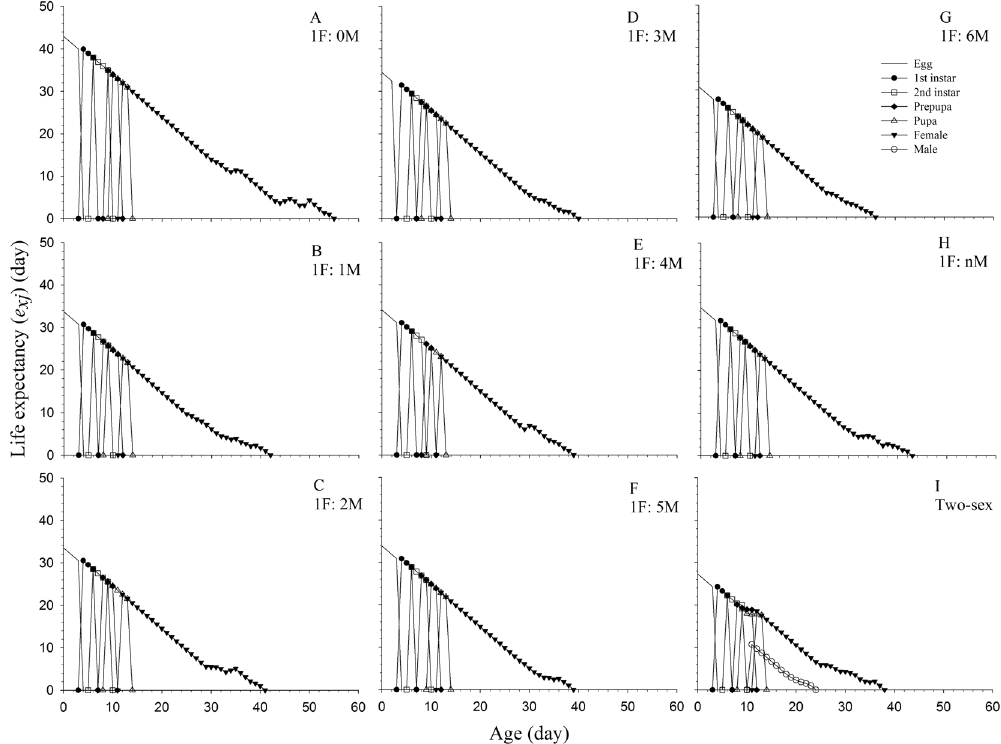
Figure 3. Age-stage life expectancy ( e xj ) of Frankliniella occidentalis at different arrhenotokous sex ratios and bisexual population. A = 1 F:0 M, B = 1 F:1 M, C = 1 F:2 M, D = 1 F:3 M, E = 1 F:4 M, F = 1 F:5 M, G = 1 F:6 M, H = 1 F:nM, I = Two-sex.